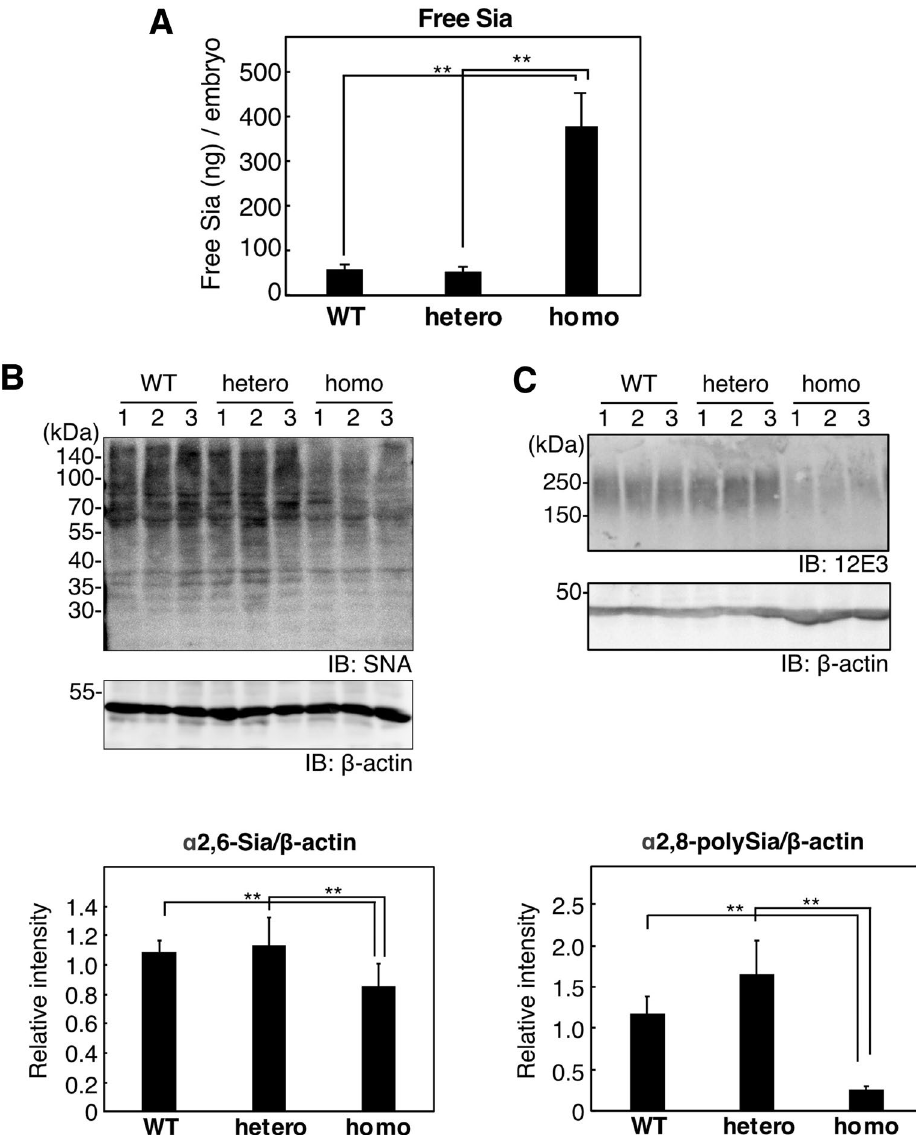
Figure 2. Free and bound Sia in the whole lysate of WT, hetero, and homo medaka of L304Q at 8 dpf. ( A ) The amount of free Neu5Ac in the lysate was quantified by the fluorometric HPLC analysis, as described in Experimentnal Procedures . The bars represent standard deviations from three independent experiments. ( B ) The α2,6-Sia epitope evaluated by a lectin blotting with SNA and ( C ) the α2,8-polySia epitope evaluated by the western blotting with anti-polySia antibody (12E3). The lysate was applied to SDS-PAGE, followed by the SNA lectin-staining ( B , upper panel ) and 12E3-immuostaining ( C , upper panel ), respectively. Lanes 1–3 stand for homogenates from three independent fry. Immunoblotting of β-actin was used as a loading control ( B , C , middle panels ). The relative amounts of the Sia epitope are also shown ( lower panels ). The bars represent standard deviations from the data obtained from three independent fish. **indicates p < 0.005. Full-length blots for ( B , C ) are presented in Supp_FigS8 and Supp_FigS9,